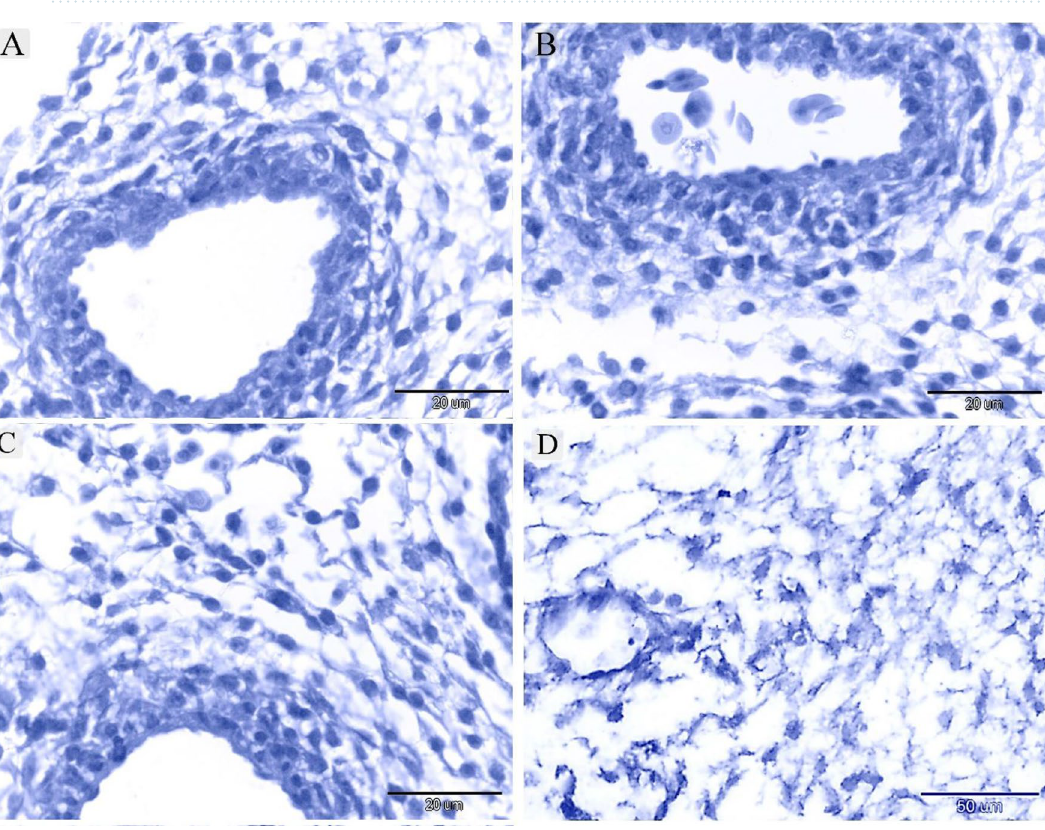
Figure 10. Negative control of IHC. ( A ) Negative control for CD34. ( B ) Negative control for VEGF. ( C ): Negative control for MMP-9. ( D ): negative control of the